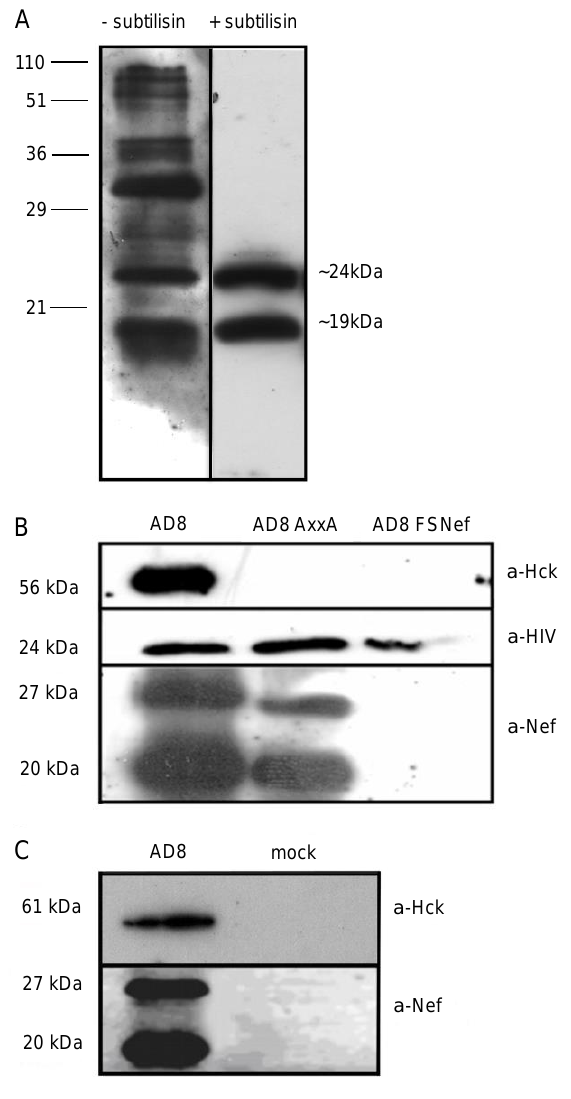
Figure 3. Nef and Hck are present in HIV-1 virions derived from 293T cell lines and primary monocyte-derived macrophages. ( A ) Immunoblots of lysates of pelleted viral material generated by transfection of 293T cells with pAD8-1, with and without subtilisin digestion, probed with HIV antisera. The molecular weights of standard markers are indicated in kDa on the left-hand side of the figure. The molecular weights on the right hand side of the figure represent the approximate size of two major reactive products which likely correspond to viral capsid and nucleocapsid proteins; ( B ) HIV-1 viral particles purified by subtilisin treatment of pelleted virus isolated from the supernatants of 293Ts co-transfected with pAD8-1, pAD8AxxA or pAD8FSNef and pHck; or ( C ) of monocyte-derived macrophages infected with AD8 or mock-infected; were subjected to SDS-PAGE and probed with anti-Hck and EH1 anti-Nef mouse monoclonal sera. Data are representative from 2 independent experiments for each cell